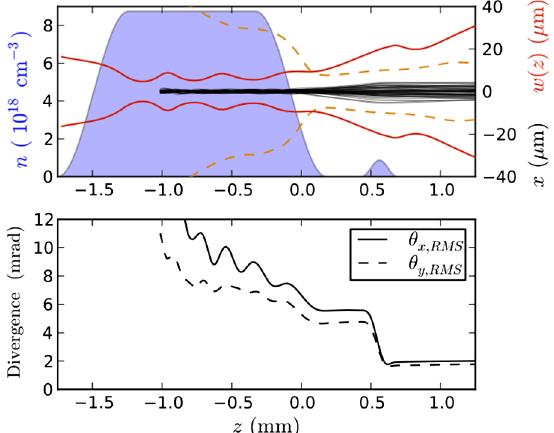
FIG. 4. Upper panel: density profile (blue), waists of the first (red, solid) and second (orange, dashed) laser pulse, and trajectories of a few injected electrons (black) in the PIC simulation. Lower panel: divergence of the